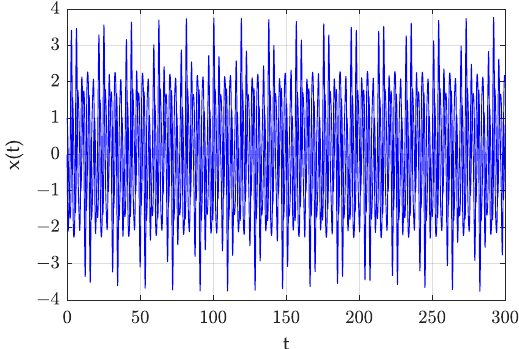
.. x + ( δ + 2 ε cos2 t ) x = 0 with ( δ = 3 , ε = 1 ).